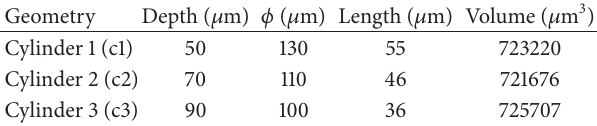
Table 2: Cylinder geometry dimensions.